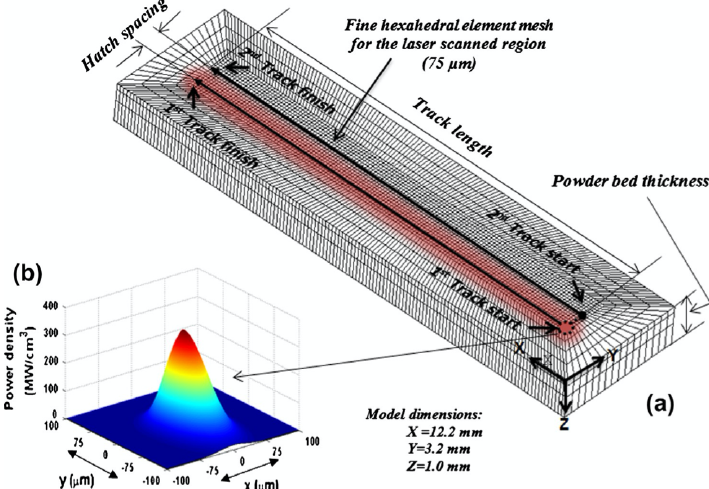
Figure 3. Details of the FEM simulation of temperature field evolution during SLM fabrication, performed by Hussein et al. [32]: ( a ) conformal mesh refinement in the laser scan region; ( b ) Gaussian laser-energy density